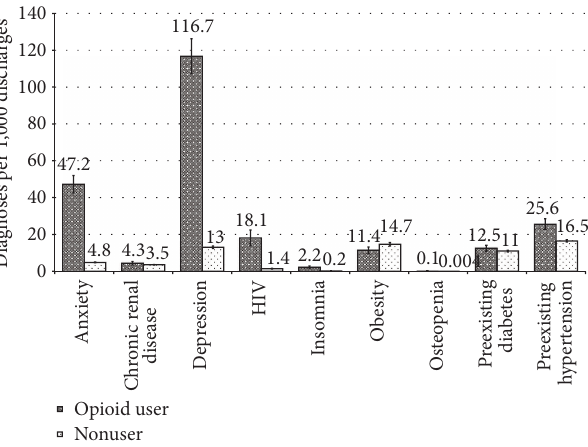
Figure 1: Rates (per 1,000 pregnancy-related discharges) of selected comorbidities, by opioid use status, among pregnancy-related dis- charges, NIS, 1998–2009. HIV = human immunodeficiency virus, NIS = Nationwide Inpatient